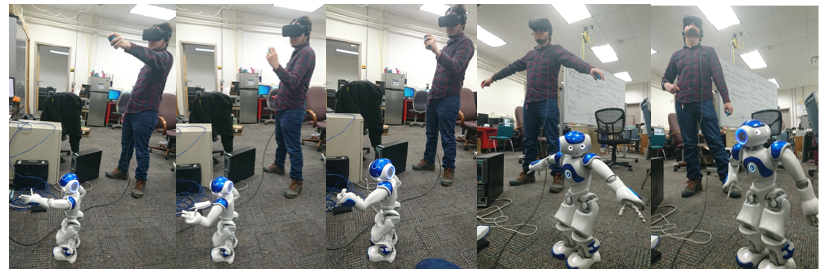
Figure 24. Process of imitation for NAO robot joint